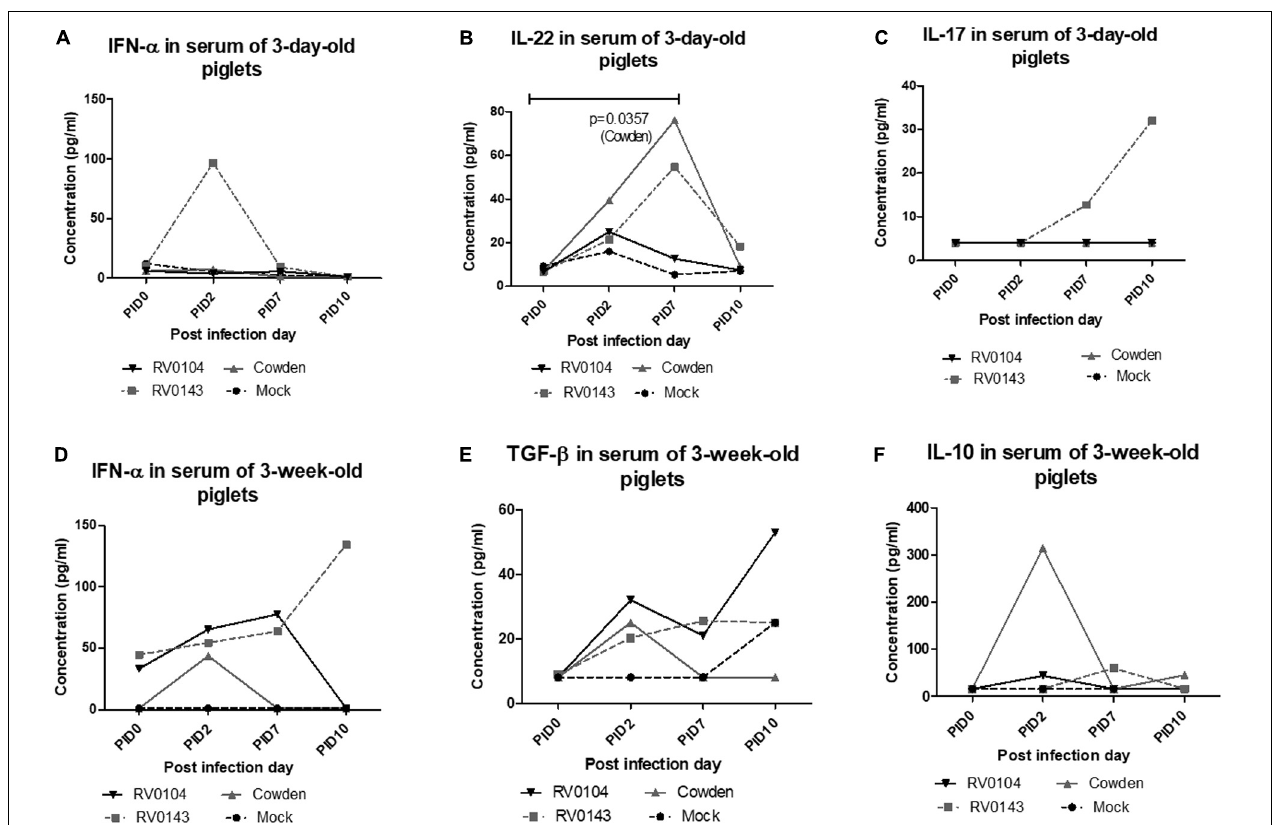
FIGURE 2 | Mean ( ± SEM) concentrations of innate, proinflammatory, Th1, and T regulatory cytokines detected in serum of 3-day-old Gn piglets inoculated with 10 5 RNA copy/ml of porcine RVC Cowden ( n = 5), RV0104 ( n = 7), and RV0143 ( n = 7) and mock ( n = 4) ( A . IFN- α ; B . IL-22, and C . IL-17) and 3-week-old Gn piglets inoculated with 10 5 RNA copy/ml of porcine RVC Cowden ( n = 5), RV0104 ( n = 7), and RV0143 ( n = 7) and mock ( n = 3) ( D . IFN- α ; E . TGF- β and F . IL-10). Serum was collected once before and three times after PRVC inoculation (PID2, PID7, and